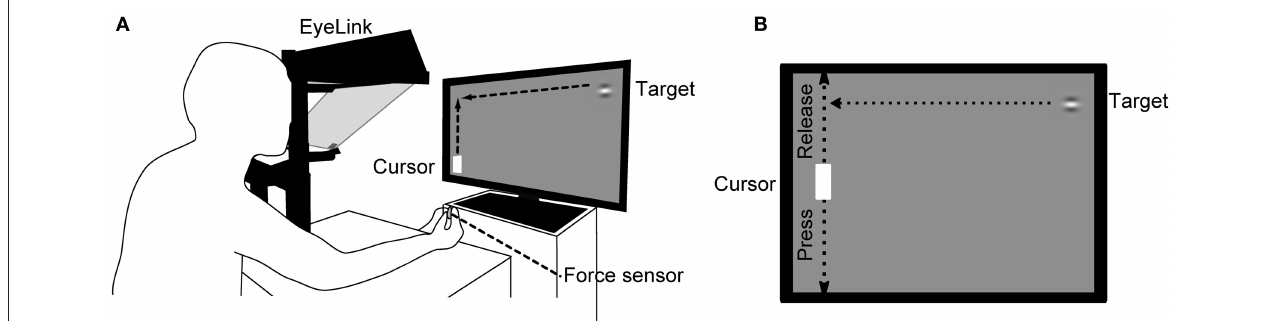
FIGURE 1 | Schema of the experimental setup. (A) The participant places his/her head on a chin rest 57cm in front of the LC display and prehends a force sensor with the thumb and index finger of the right hand. The force-sensor output determines the cursor movement in the vertical direction on the left side of the display. Eye movements are recorded using an eye-tracking system during the task. (B) The cursor is positioned at the top of the display when the force sensor is not pressed and moves down in proportion to the force given to the sensor. Target speeds used were 1,000, 2,000, 3,000, 4,000, 5,000, 6,000, and 7,000